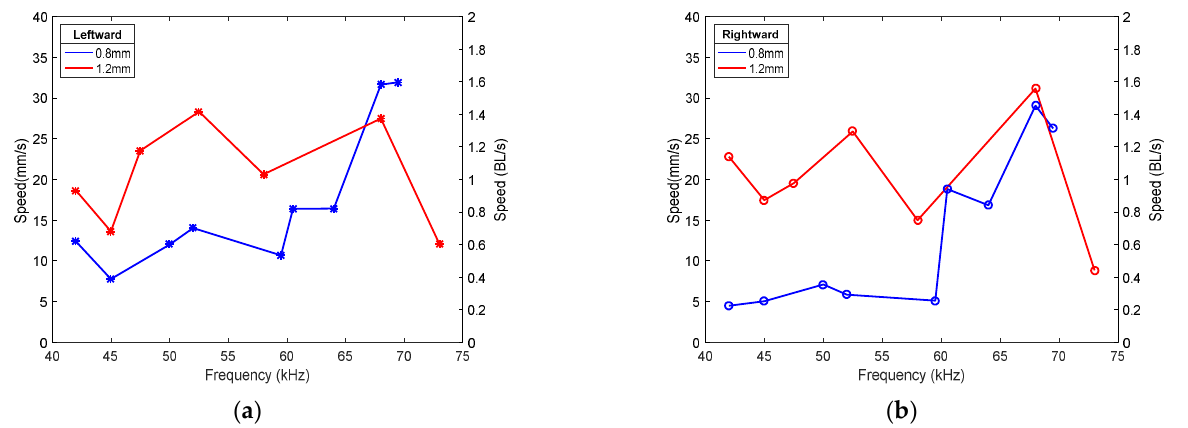
Figure 8. Speed of the TW robot with the low-order combination with 0.8 and 1.2 mm long legs for ( a ) leftward movement, and ( b ) rightward movement.